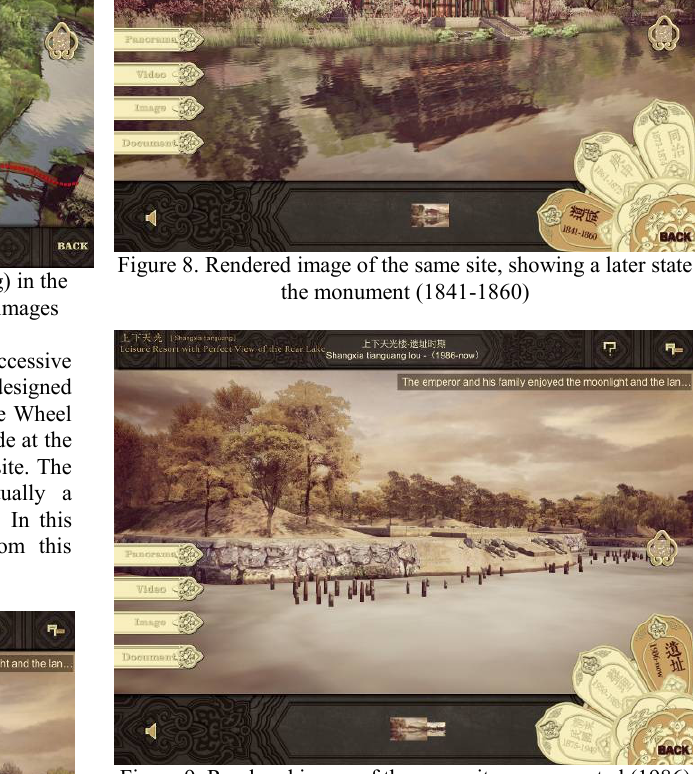
Figure 9. Rendered image of the same site, as excavated (1986)